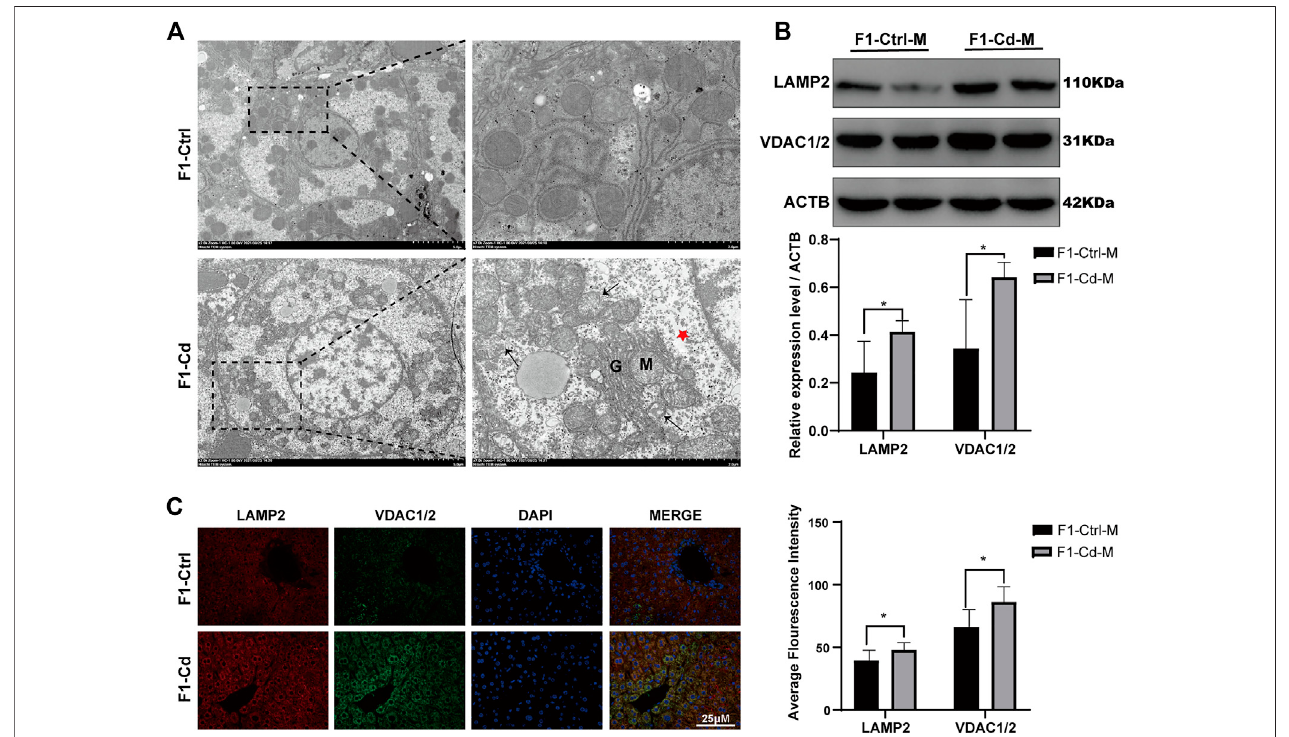
FIGURE7| Effects ofCdexposureon progeny liver. (A) Transmission electron microscopy(TEM)results ofthe liverinmice. Thered pentacle representsedemaof thelivercells;theblackarrowsmanifestthemitochondrialmembranerupture;Mmitochondria;G,Golgiapparatus. (B) TheproteinlevelsofLAMP2andVDAC1/2inmice liversat16weeksweremeasured bywesternblotting( n (cid:1) 3). (C) Theimmuno fl uorescence and quanti fi cationanalysisofLAMP2 andVDAC1/2intheliversofF1 miceat 16 weeks (scale bar (cid:1) 25 μ m, n (cid:1) 3). All results are expressed as the mean ± SD. Labeled asterisk represents statistical signi fi cance compared with the respective control group. * p < 0.05, ** p < 0.01, *** p < 0.001 and **** p <